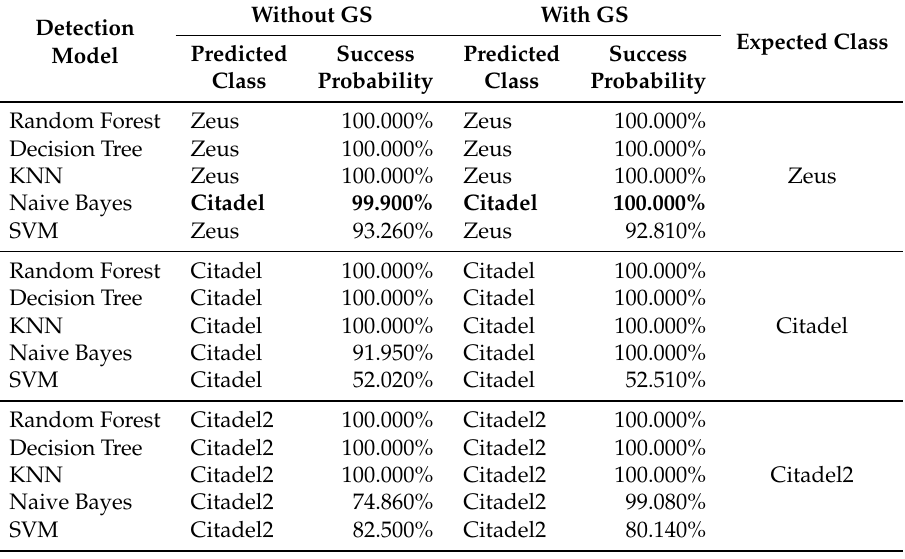
Table 13. Prediction results using majority classes included on the ISOT HTTP Botnet